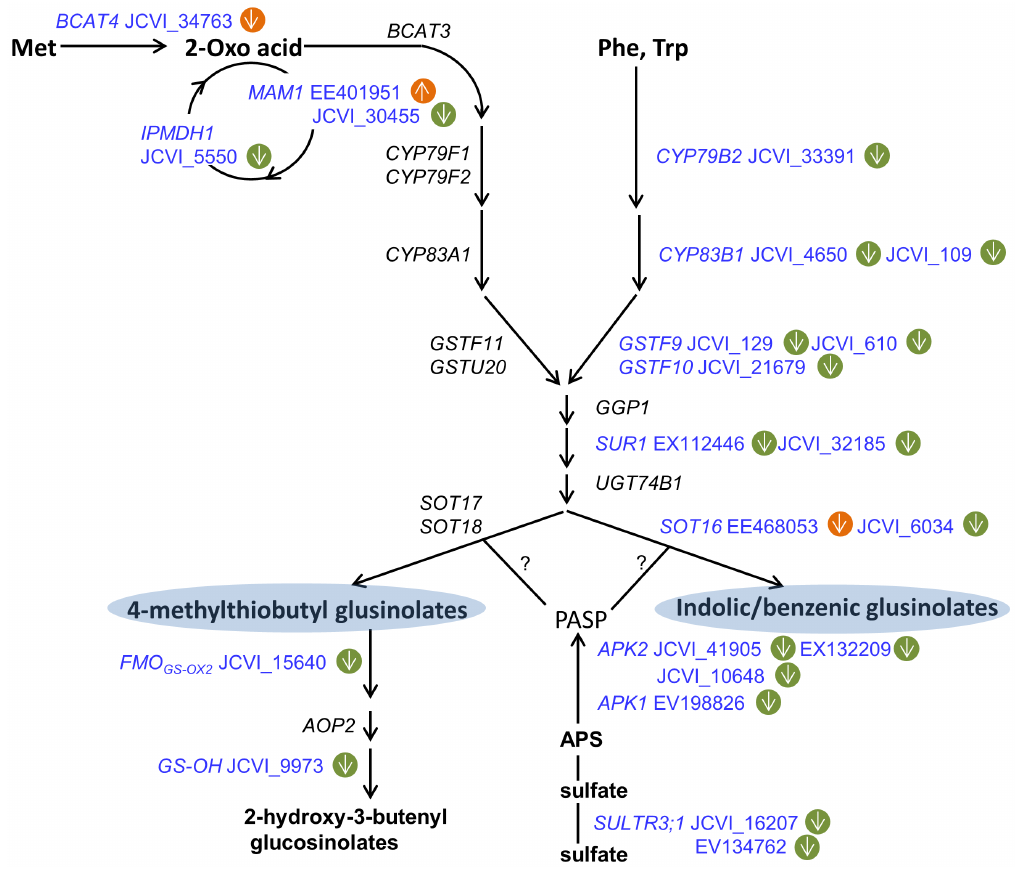
Figure 4. Differentially expressed genes involved in the aliphatic and indolic glucosinolate biosynthetic pathways. The green circle represents the SW, and the yellow circle indicates seeds. Arrows pointing up indicate increased expression; arrows pointing down indicate decreased expression. Abbreviations: BCAT, branched-chain amino acid aminotransferase; MAM, methylthioalkylmalate synthase; IPMDH, isopropylmalate dehydrogenase; CYP, cytochrome P450; GST, glutathione transferase; GGP1, c -glutamyl peptidase 1; SUR1, C-S lyase; UGT, glucosyltransferase; SOT, sulfotransferase; FMO GS-OX , flavin monooxygenase; AOP2, 2-oxoglutarate-dependent dioxygenase; GS-OH, 2-oxo acid-dependent dioxygenase; APS, adenosine 5 9 -phosphosulfate; APK, APS kinase; SULTR, sulfate transporter; PAPS, 3 9 -phosphoadenosine-5 9 -phosphosulfate. This scheme was based on analyses by Maruyama-Nakashita et al. (2006) [97] and Sønderby et al. (2010) [62]. functional categories exhibiting 2.1- to 8.1-fold changes